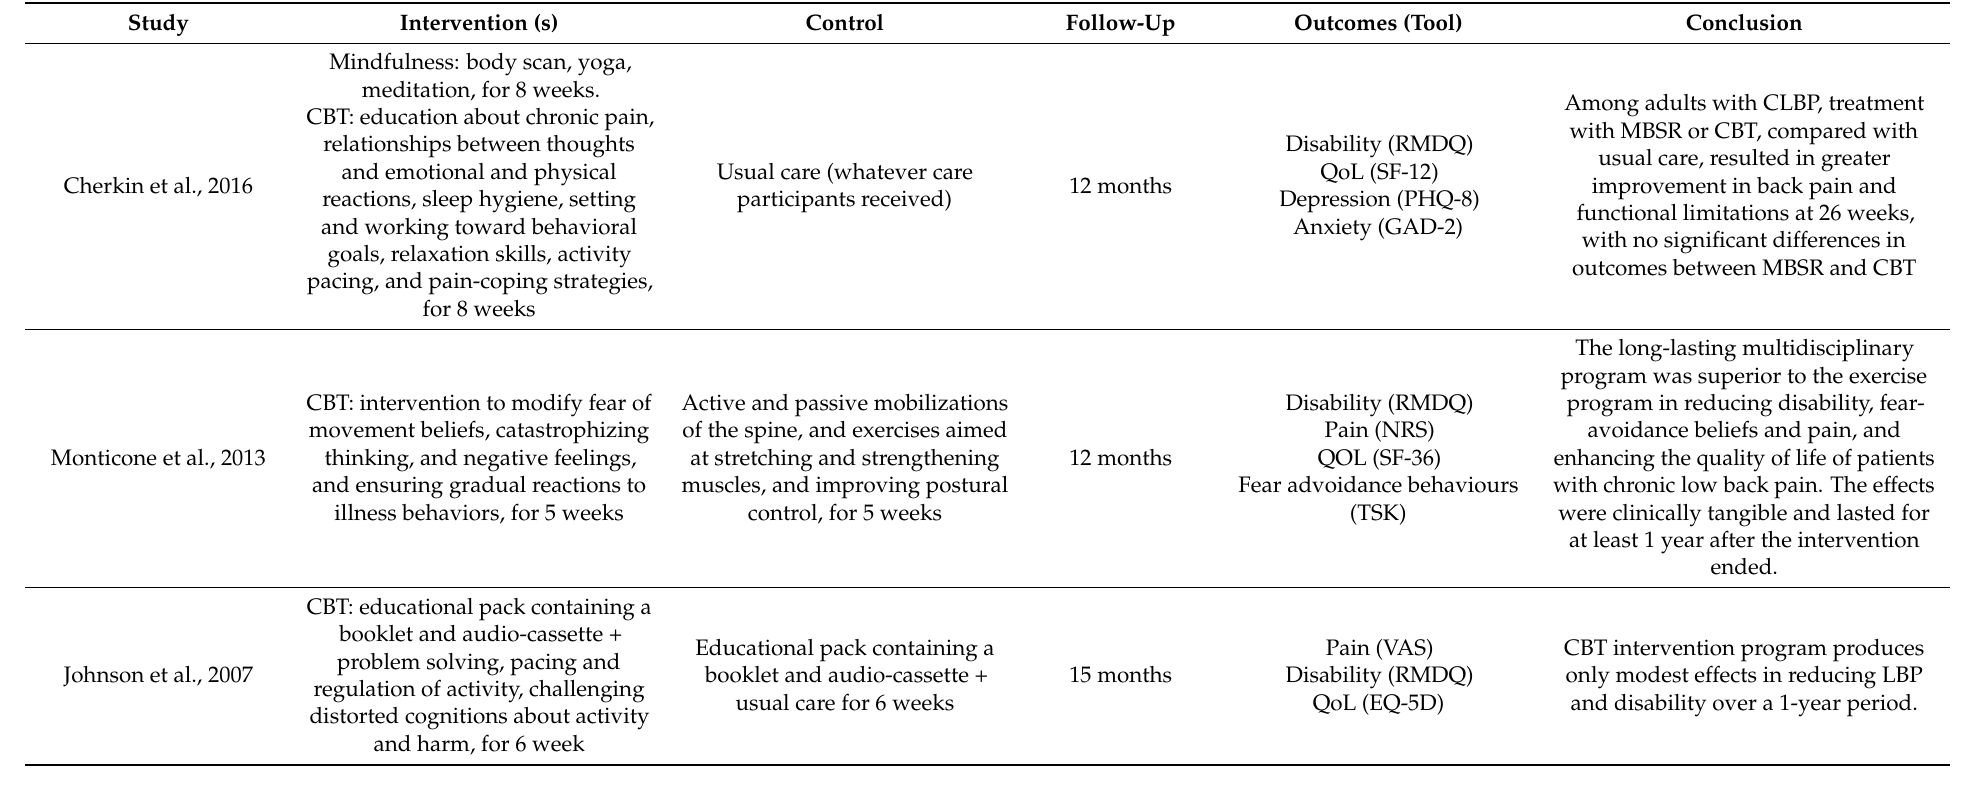
Table 2. Clinical results of the included